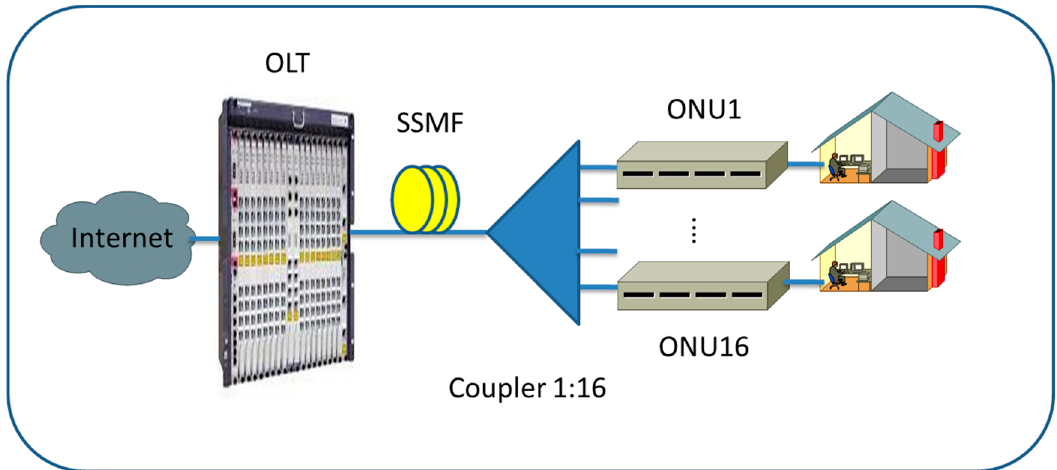
10 of 14 Figure 8. Eye diagrams: ( a ) for the first user; ( b ) for the second user; ( c ) for the third user; ( d ) for the